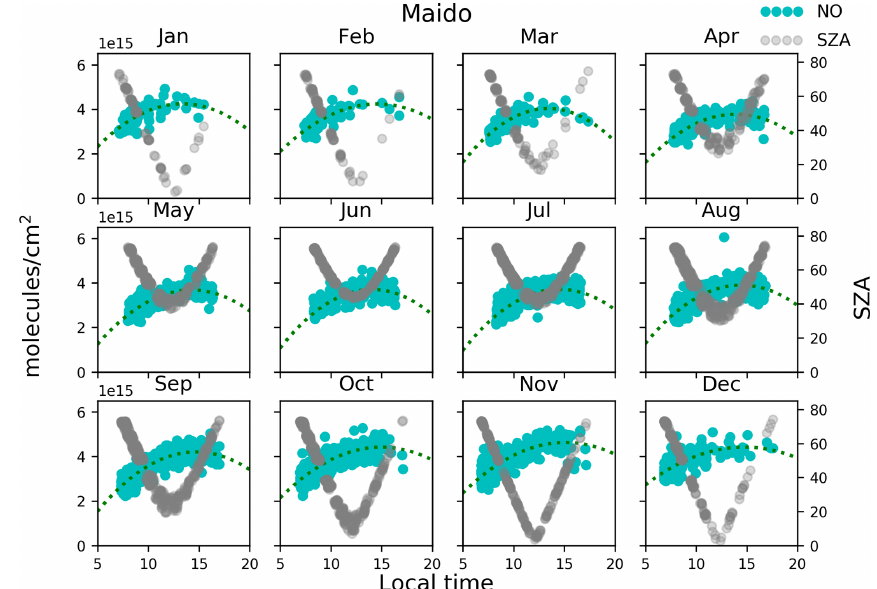
Figure 6. The diurnal variation in stratospheric NO partial column at Maïdo, together with the solar zenith angle (gray dots). The stratospheric NO partial columns are fitted with a second-order polynomial fitting (dotted cyan line).